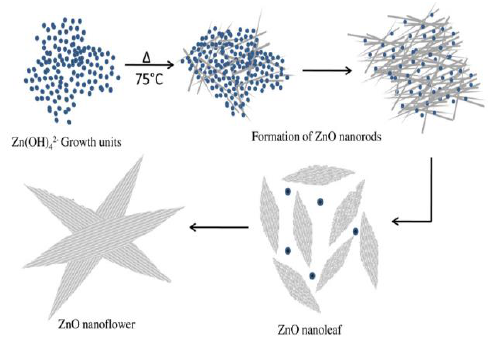
Figure 9. Successive stages for forming ZnO nanoflower: self-assembly of zincate to nanoparticles, nanorods, and nanoleaves. Reproduced from [92] with permission of Elsevier.